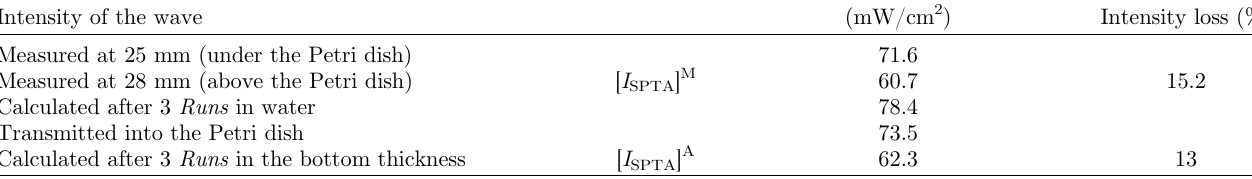
Table 5. Analytical calculation of the intensity and loss for the 1 MHz-transducer. Intensity of the wave Measured at 25 mm (under the Petri dish)